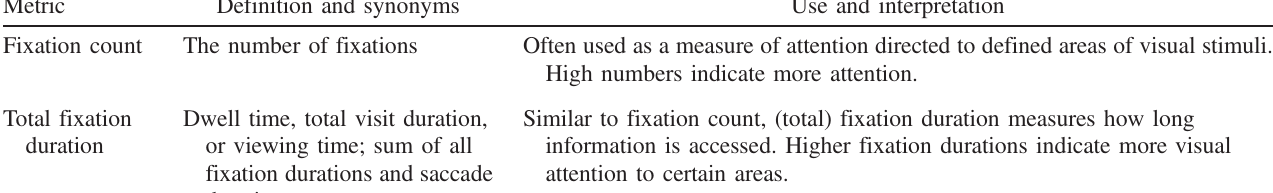
TABLE III. Overview of the most common eye-tracking metrics reported in the PER studies and their relevance.